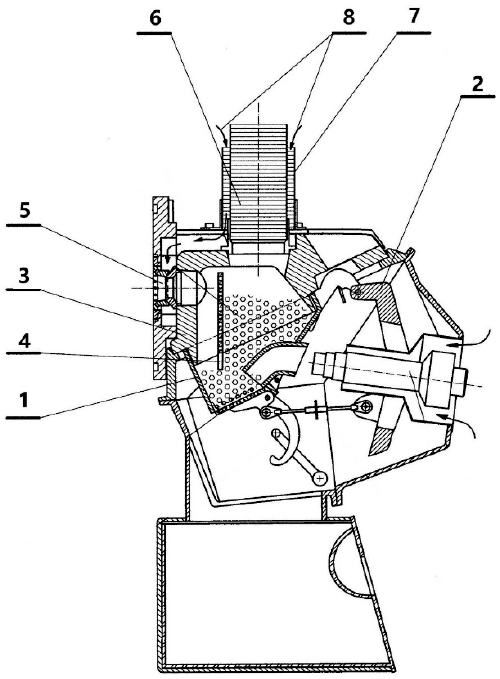
Figure 2. The scheme of gasification burner [64]: (1) the grate; (2) the counterweight; (3) the burner body; (4) perforated partition; (5) the nozzles; (6), (7) the spaces supplying secondary air; (8) secondary air intake.